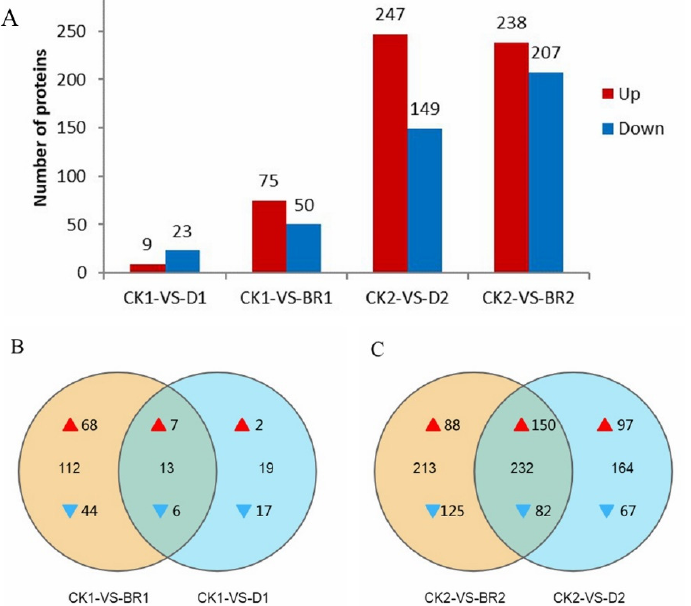
Figure 5. Number of differentially expressed proteins (DEPs) identified between groups ( A ), and Venn diagrams showing the number of DEPs between 24-epibrassionlide (BR) and drought (D) conditions at the early phase ( B ) and late phase ( C ), respectively. The numbers attached behind the sample identifiers represent the time point at which the samples were collected: 1 and 2 represent 8 and 18 days of treatment, respectively.